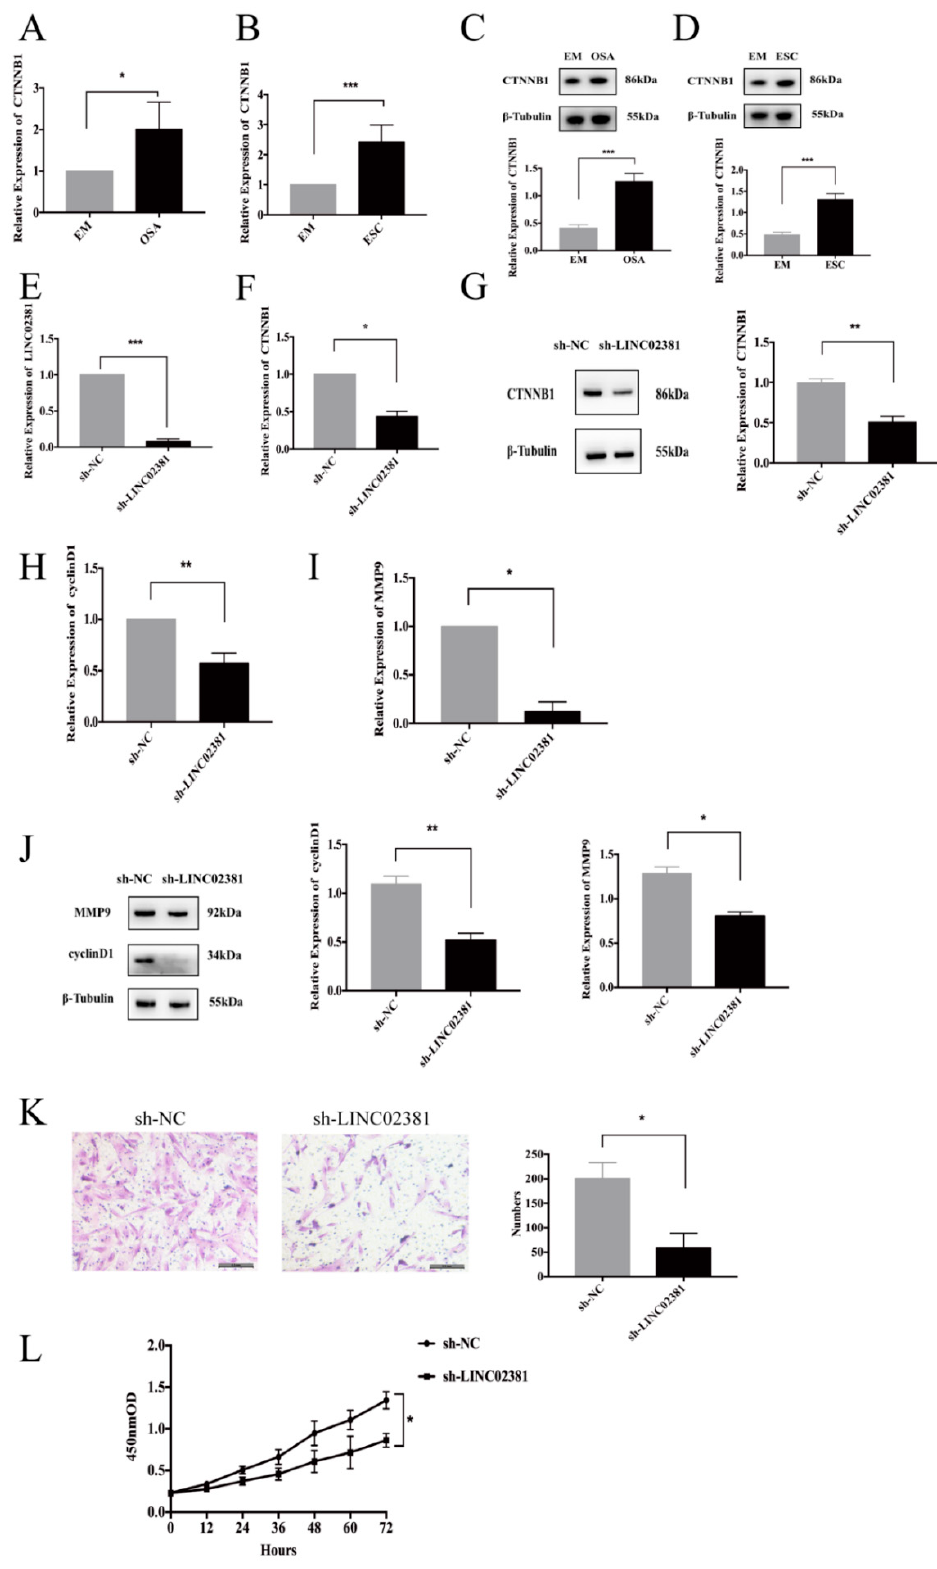
Figure 3. LINC02381 enhances CTNNB1 expression and the proliferation and invasion of ESCs. ( A ) Paired OSA and EM samples were collected for qRT-PCR to quantify the mRNA expression of CTNNB1 ( n = 15, P < 0.05). ( B ) Paired ESCs and EMs were collected for qRT-PCR to quantify the mRNA expression of CTNNB1 ( n = 13, P < 0.001). ( C ) Paired OSA and EM samples were collected for Western blotting to determine the protein expression of CTNNB1 ( n = 9, P < 0.001). ( D ) Paired